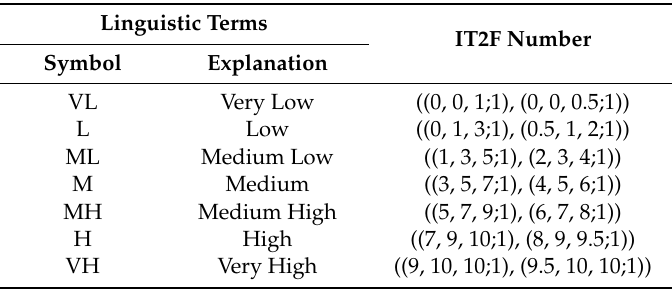
Table 8. Vocabulary of linguistic